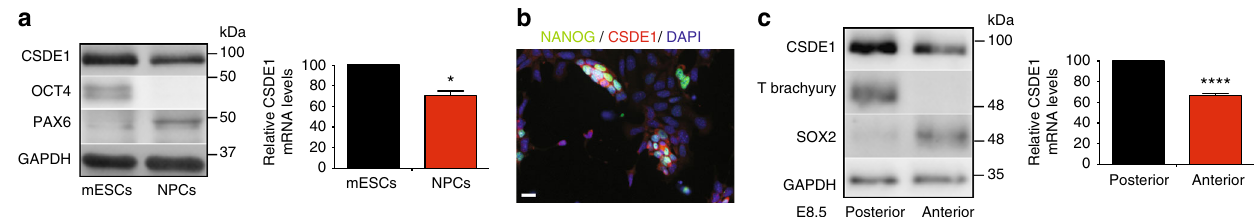
Fig. 2 CSDE1 protein levels decrease with differentiation in developing mouse embryonic tissues. a Western blot analysis with antibody to CSDE1 of mouse ESCs (mESCs) and derived NPCs. The graph represents the CSDE1 relative percentage values (corrected for GAPDH loading control) to mESCs (mean ± s.e.m. of two independent experiments). b Immunocytochemistry of mESCs and differentiated cells with antibody to CSDE1. NANOG and DAPI staining were used as markers of pluripotency and nuclei, respectively. Scale bar represents 20 μ m. c Western blot analysis of primitive streak and streak-enriched tissues (posterior) and neural plate and neural-enriched tissues (anterior) from mouse embryos (embryonic day (E)8.5)). T (brachyury) and SOX2 staining were used as markers of posterior and anterior parts, respectively. The graph represents the CSDE1 relative percentage values (corrected for GAPDH loading control) to posterior part (mean ± s.e.m. of three independent experiments). All the statistical comparisons were made by Student ’ s t-test